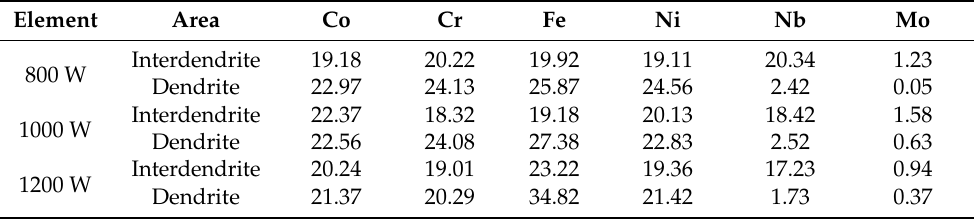
Table 3. Chemical composition of the ((CoCrFeNi) 95 Nb 5 ) 99 Mo 1 HEA coatings prepared under different laser beam power (at.%).